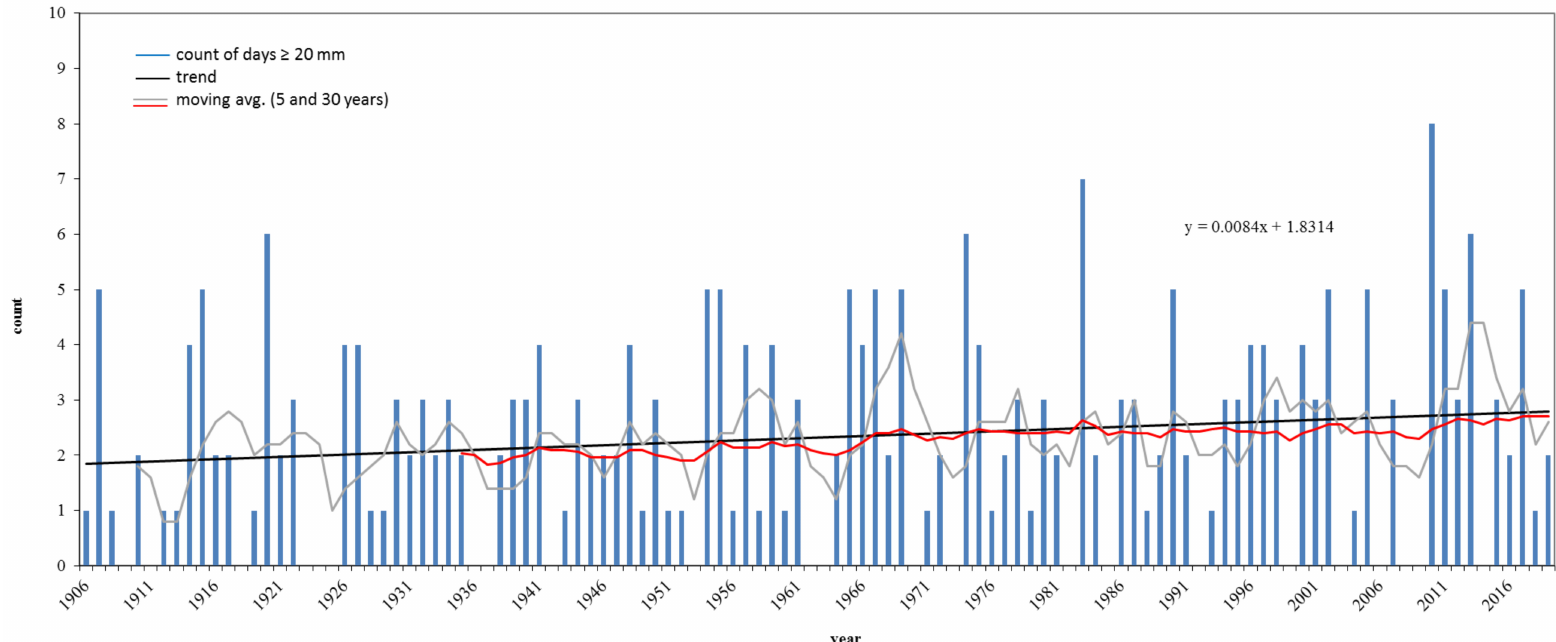
Figure 8. Heavy rainfall days with ≥ 20 mm and trend at the lowland station